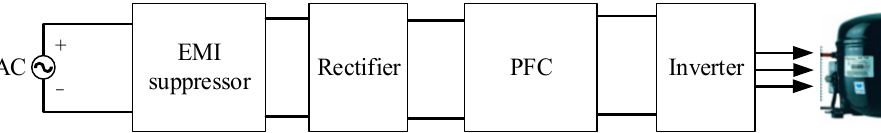
Figure 1. Architecture of temperature control system for refrigerated cabinets. Figure 2. Configuration of the compressor drive developed.